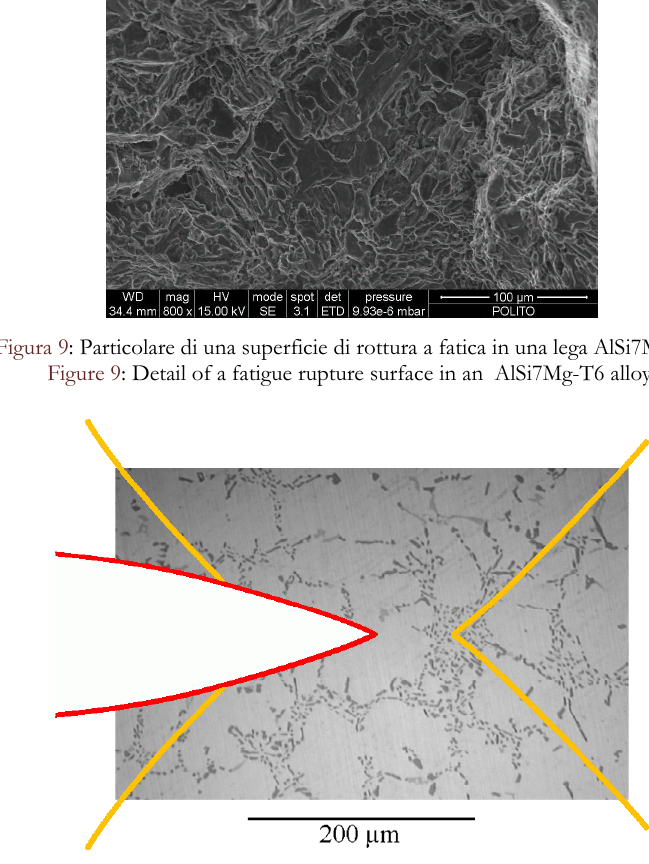
Figura 10: Zona plastica di fronte all’apice della cricca di fatica propagantesi in una lega AlSi7Mg-T6. Figure 10: Plastic zone in front of the fatigue crack tip growing in an AlSi7Mg-T6